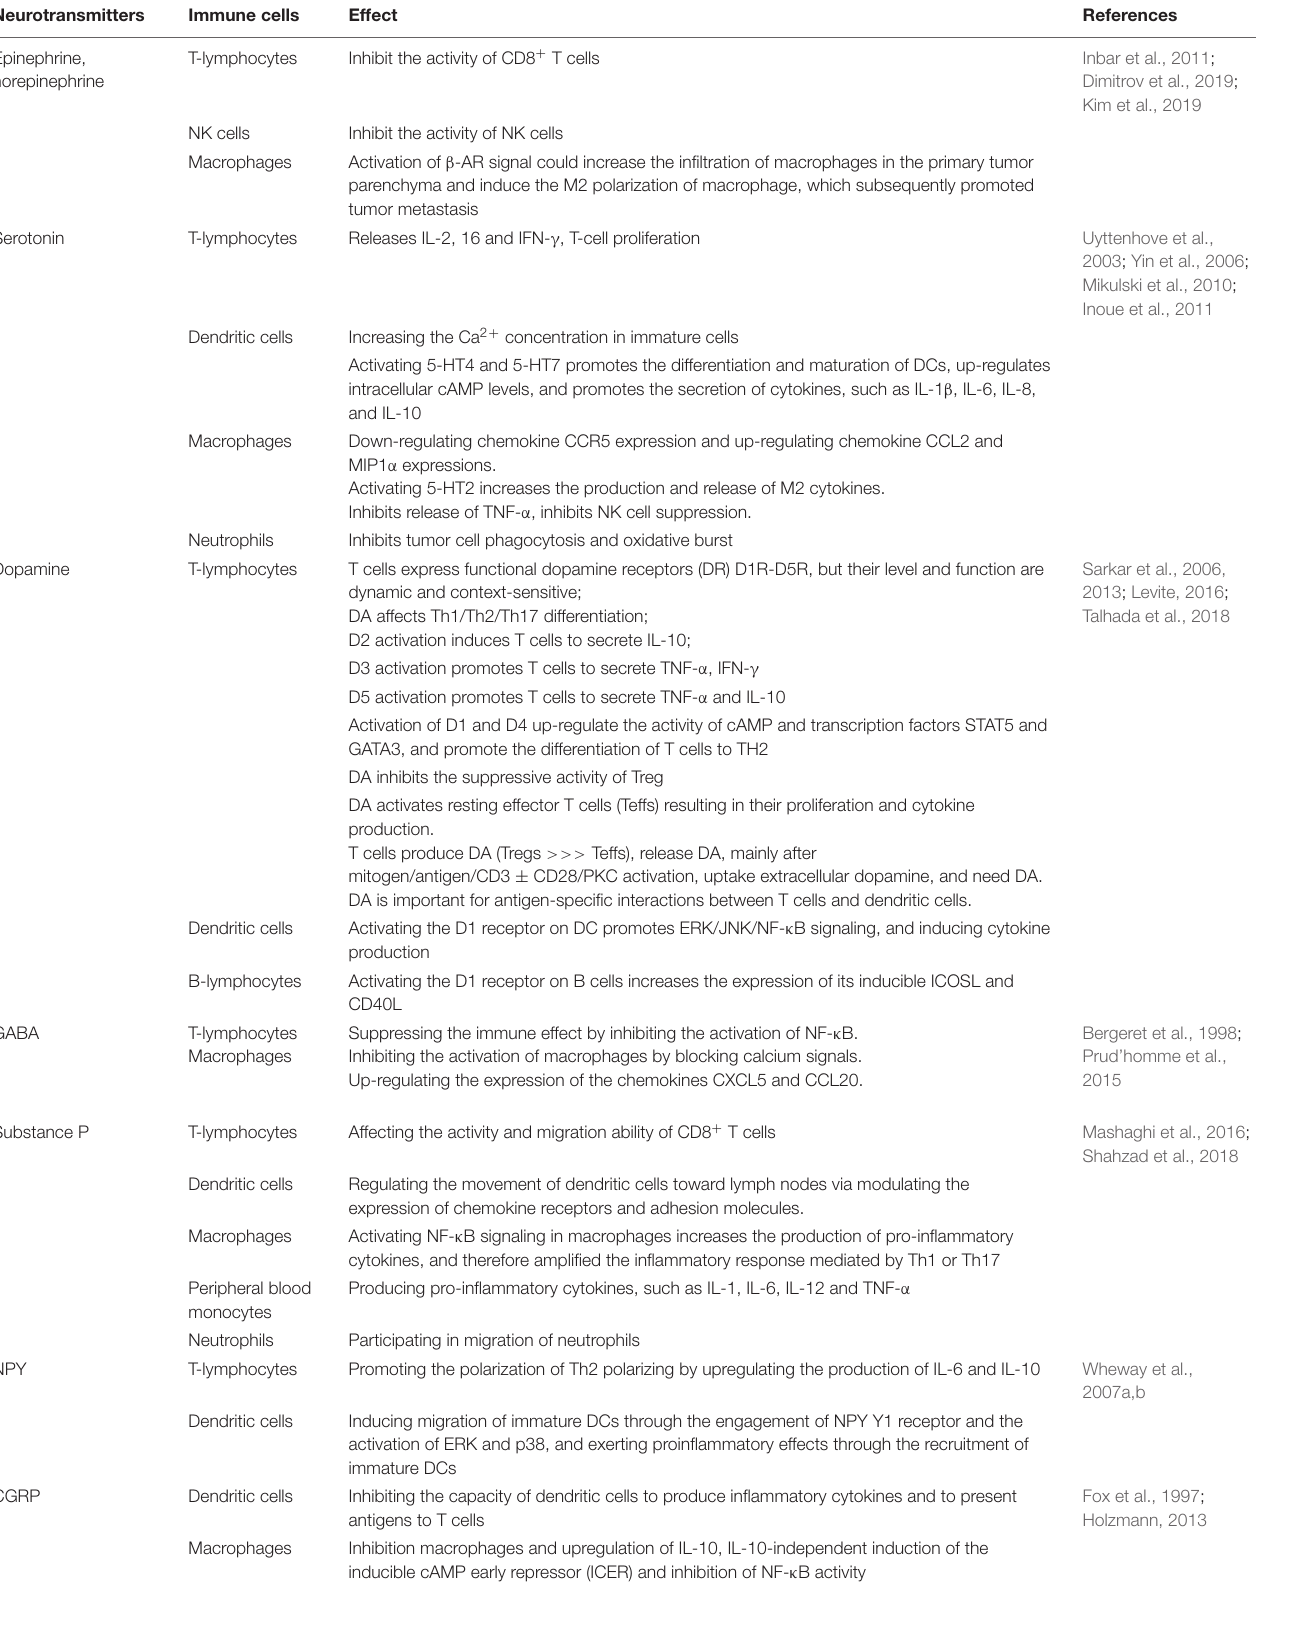
TABLE 3 | Summary of the functions of neurotransmitters on immune cells.